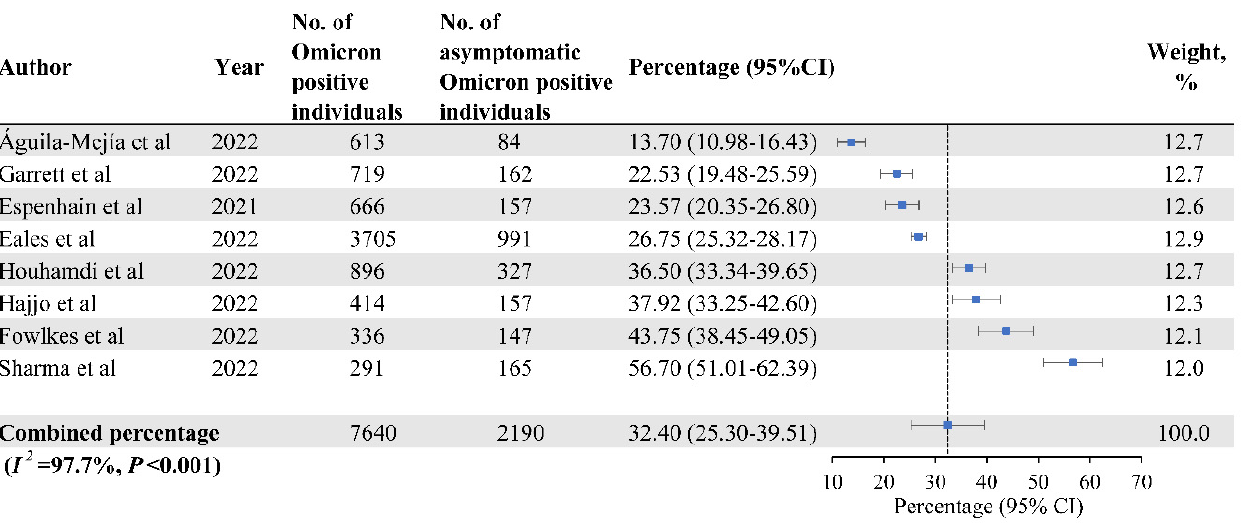
of 32.40% (95% CI: 25.30–39.51%). Heterogeneity among studies was high ( I 2 = 97.7%; p < 0.001) (Figure 2).